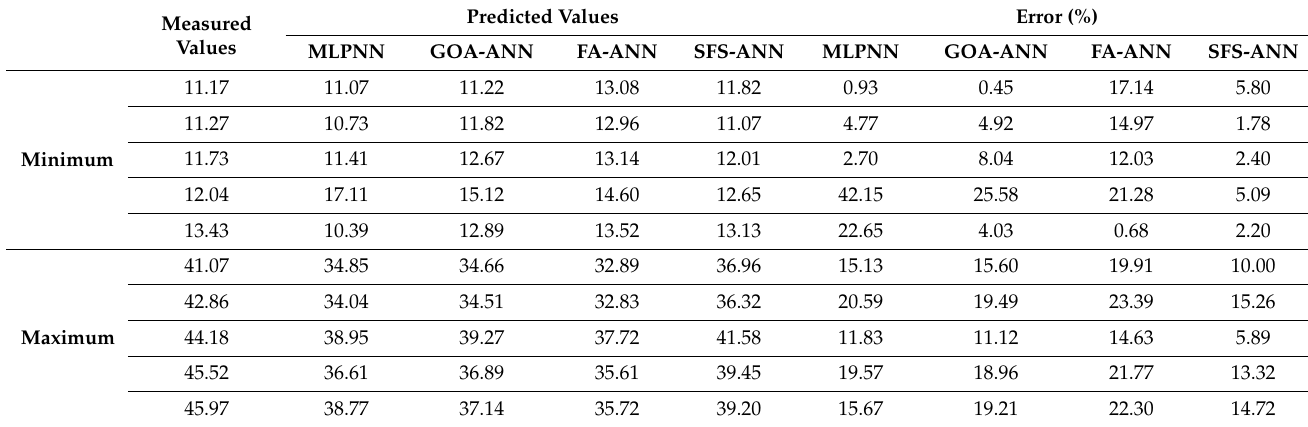
Table 2. Relative errors for predicting five maximum/minimum CL values.